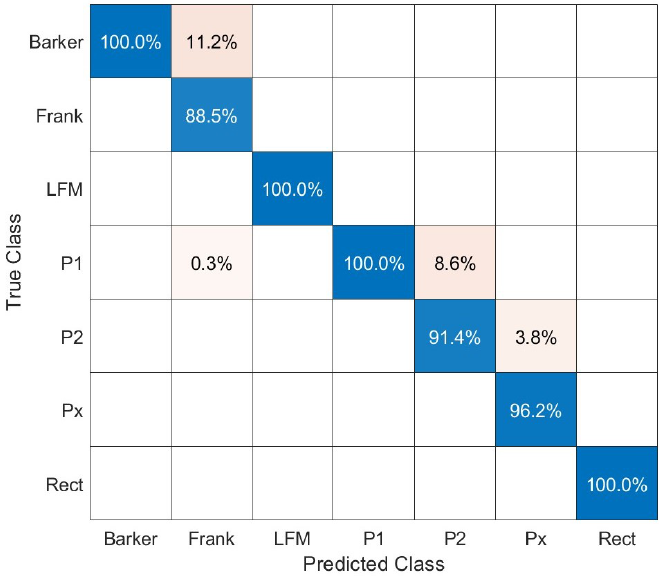
Figure 12. Confusion matrix for WVD with Kaiser window parameters L = 101, α = 1.